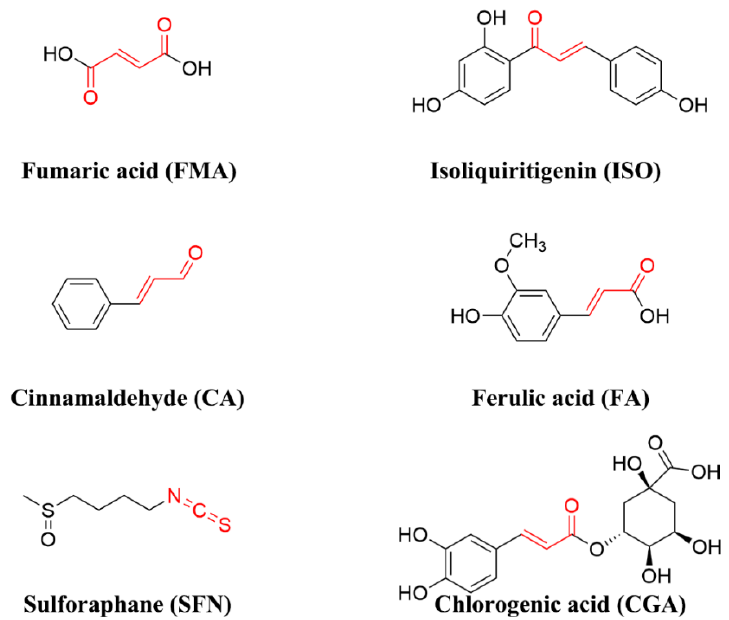
Figure 1. Structures of the investigated FECs.